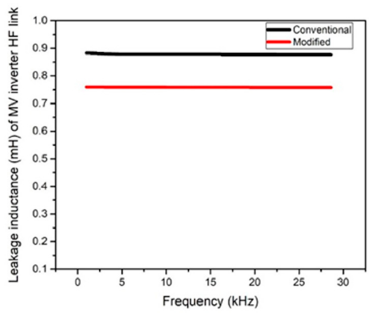
Figure 12. Toroidal transformers at 180° sectored winding, leakage inductance comparison between the